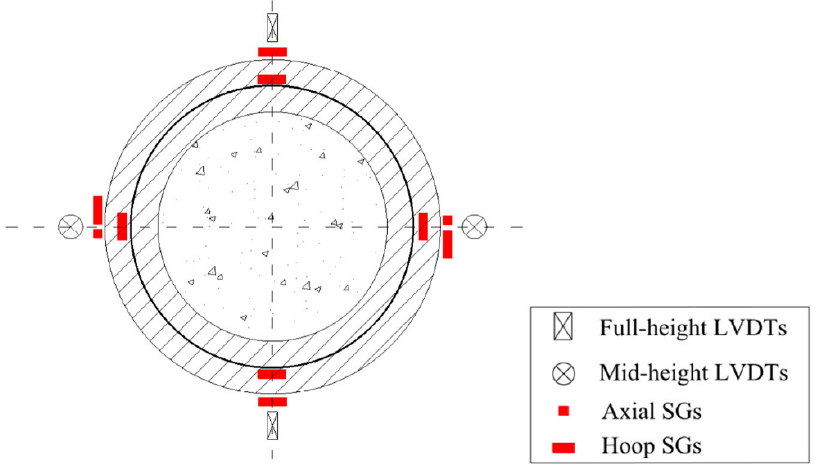
Figure 7. Locations of SGs and LVDTs for test columns.